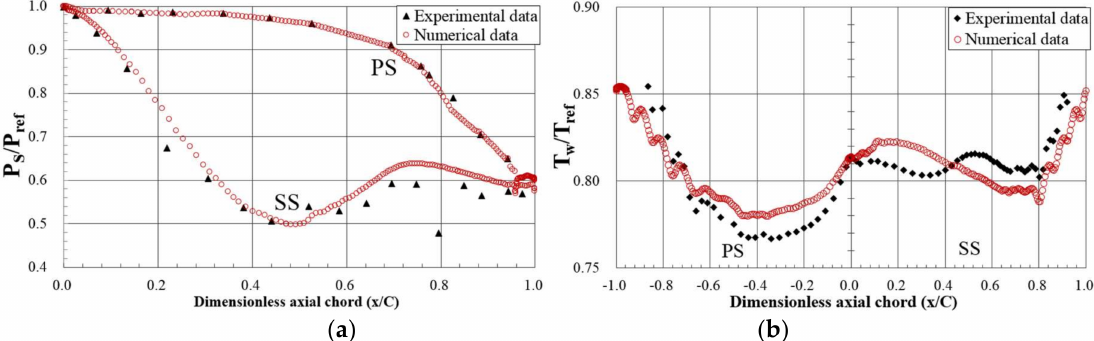
Figure 7. Comparisons between experimental and numerical results at midspan ( a ) pressure and ( b ) temperature